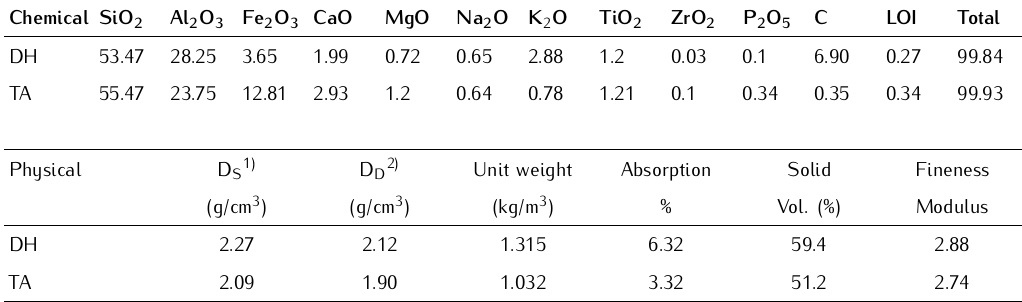
Table 2. Chemical and physical composition of domestic PA (weight %).